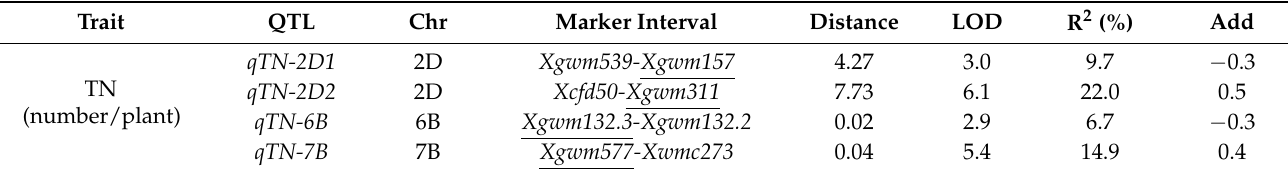
Table 2. Detected QTLs for wheat seedling traits in relation to nutrient